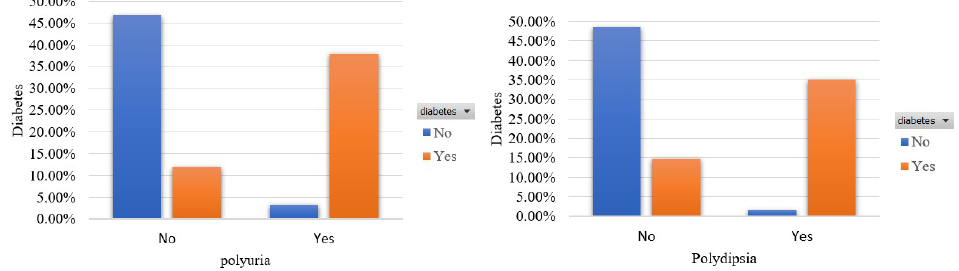
Figure 2. Participants’ distribution in terms of polyuria and polydipsia in the balanced